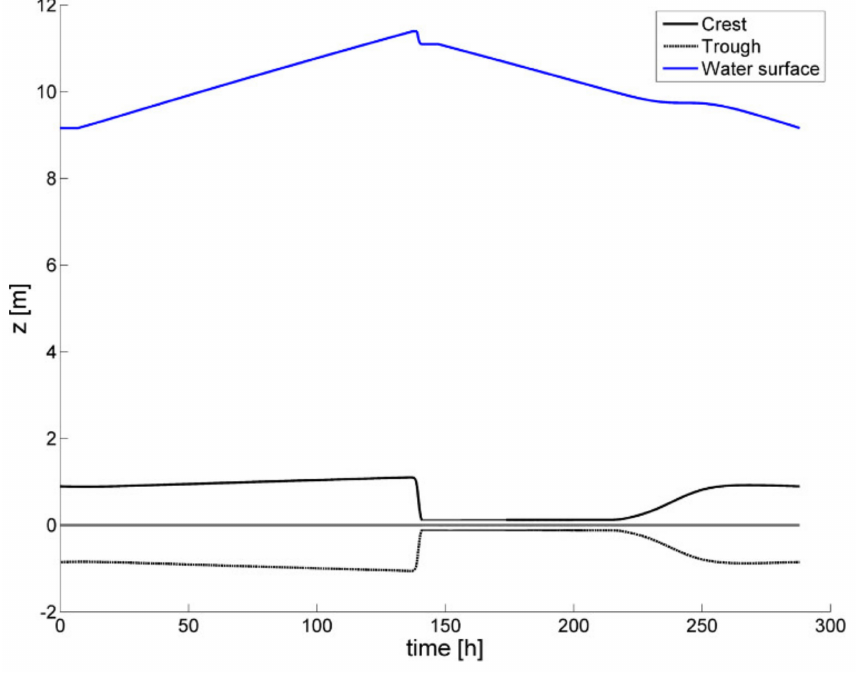
Figure 18. Dune crest and trough position (black lines) and water depth (blue line) over time, using the more extreme river